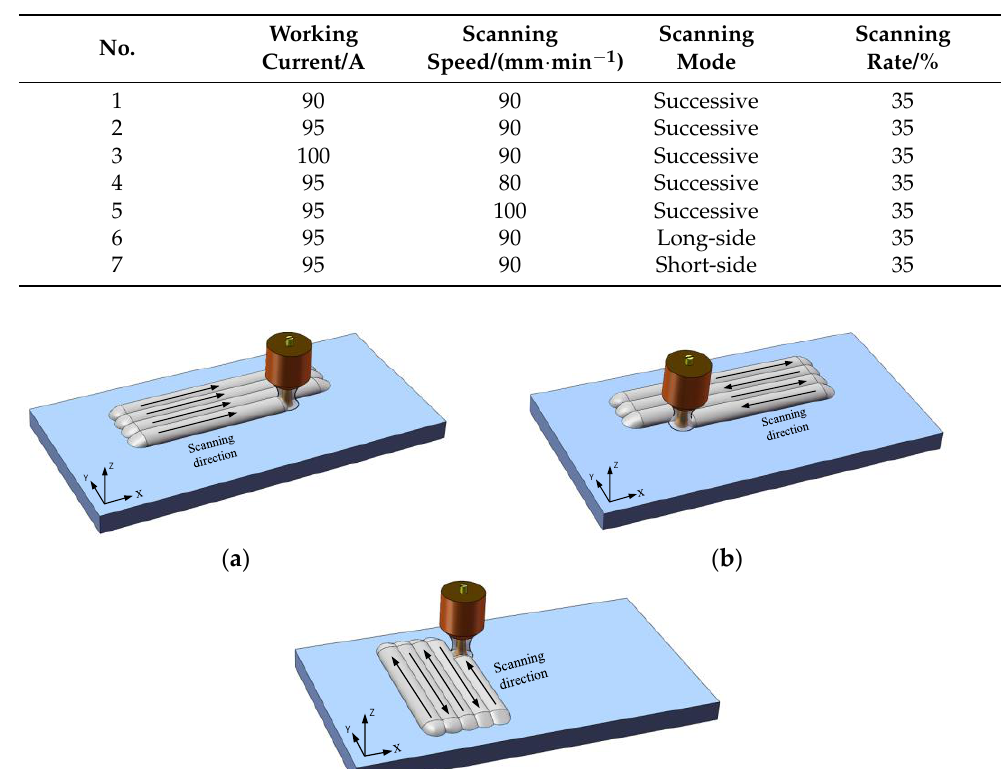
Table 1. Design of plasma cladding simulation test.